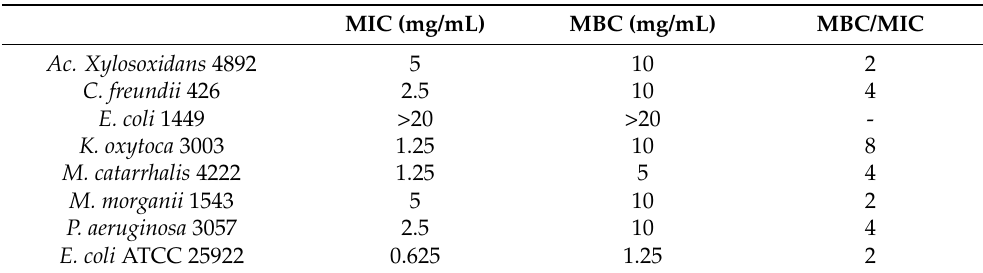
Table 4. The minimum inhibitory concentrations (MIC) and the minimum bactericidal concentrations (MBC) of A. vera